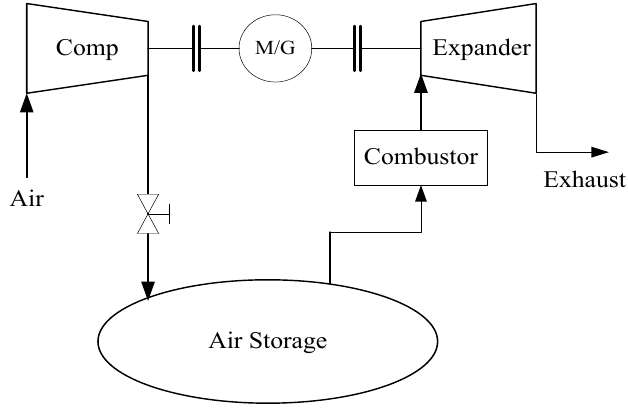
Figure 1. Conceptual diagram of the first-generation compressed air energy storage (CAES) power plant.